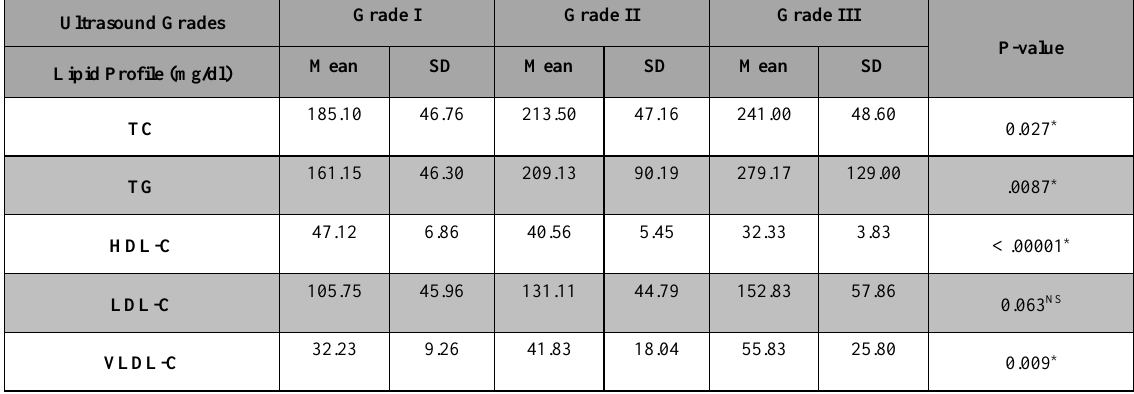
Table 3. Comparison of lipid changes in different grades of NAFLD.